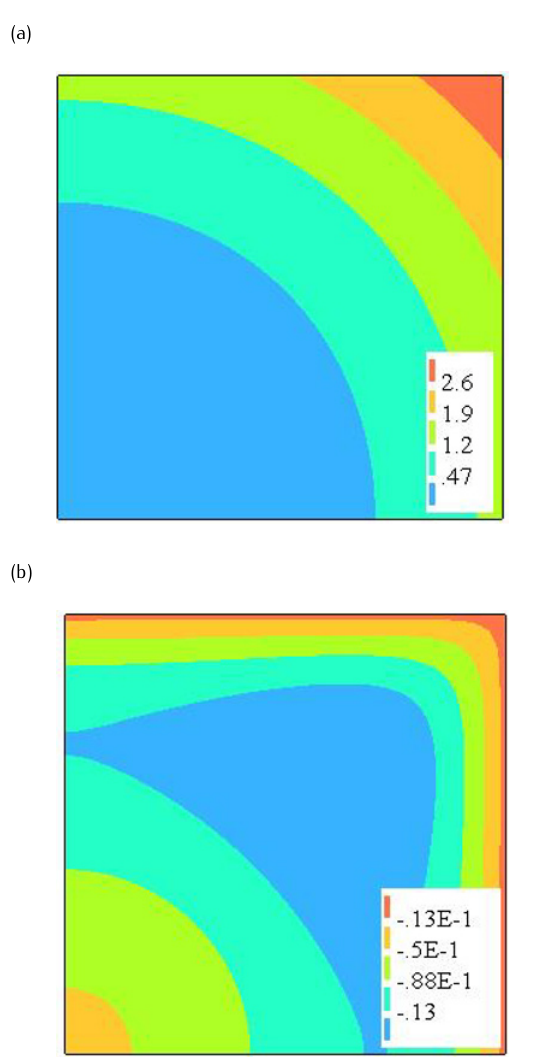
Figure 22. Distribution of vertical deformations [mm]: (a) Free boundaries, (b) Fixed boundaries.